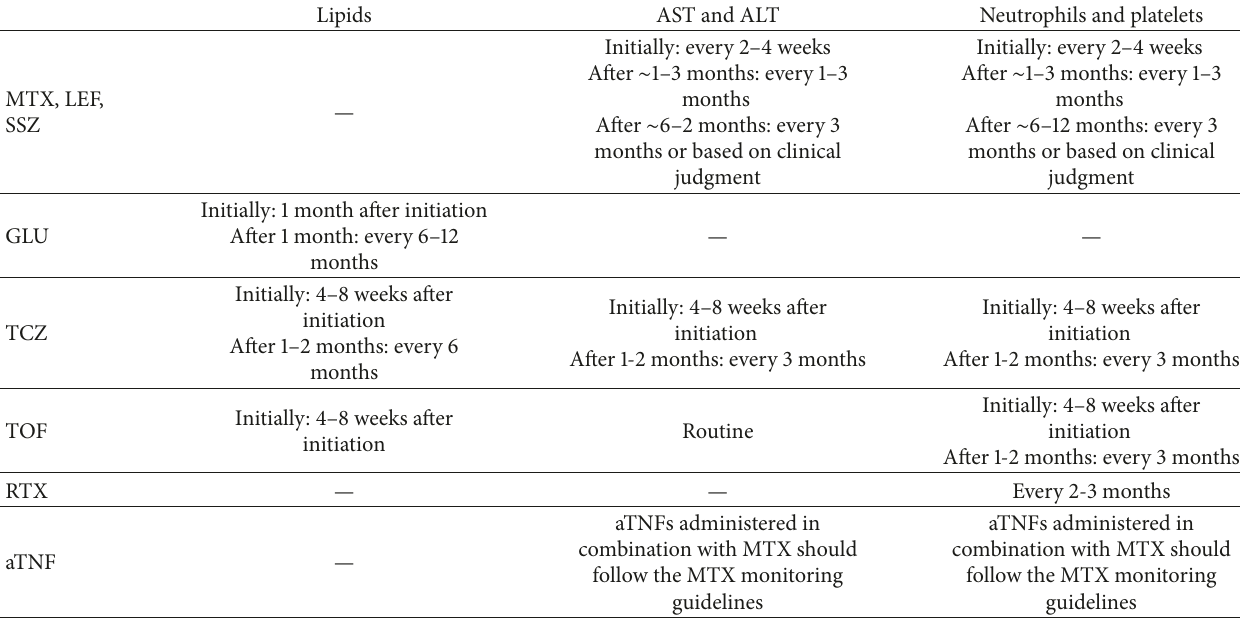
Table 6: Summary of recommended frequencies of laboratory monitoring for patients with RA receiving DMARDs a . Lipids AST and